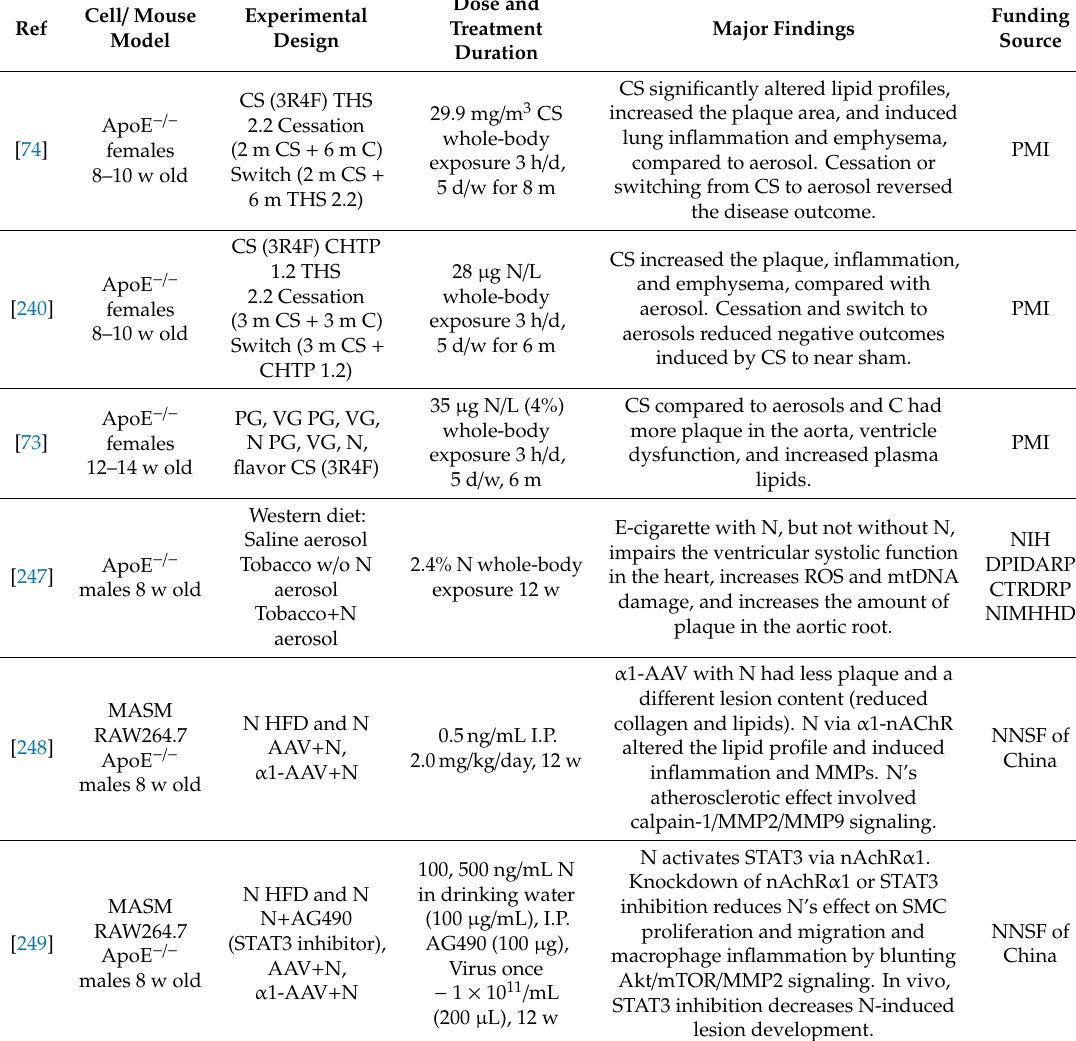
Table 1. Tobacco and nicotine in atherosclerosis: cell and animal